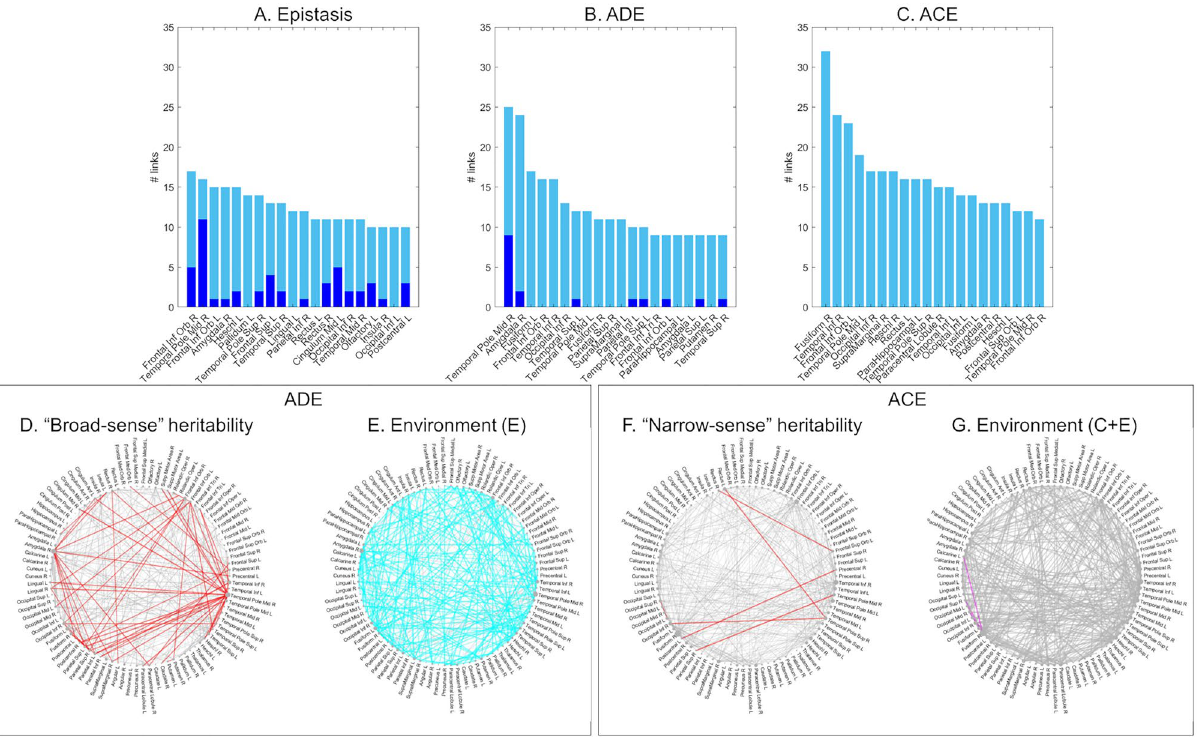
Figure 3. ROI sorting based on link-level effects. A-C. Bar plots representing in light blue the number of functional connections influenced by epistasis ( A ), ADE factors ( B ), and ACE factors ( C ) in descending order in the 20 top ranking ROIs. Network links with significant correlation differences ( p < 0.05) extracted from Fisher’s Z statistics between MZ and DZ pairs are highlighted in dark blue in panels ( A , B ). ( D – E ) Functional connections suitable for ADE model weighted for their genetic ( D ) and environmental ( E ) contributions. In D, links with “broad-sense” heritability > 50% are highlighted in red. In E, links with unique environmental effects ( E ) > 50% are highlighted in cyan. F-G. Functional connections suitable for ACE model weighted for their genetic ( F ) and environmental ( G ) contributions. In G, links with “narrow-sense” heritability > 50% are highlighted in red. In G, links with common environmental effects (C) > 50% are highlighted in magenta. Panels were created with Matlab R2019b software (http:// www. mathw orks. com), assembled with Microsoft